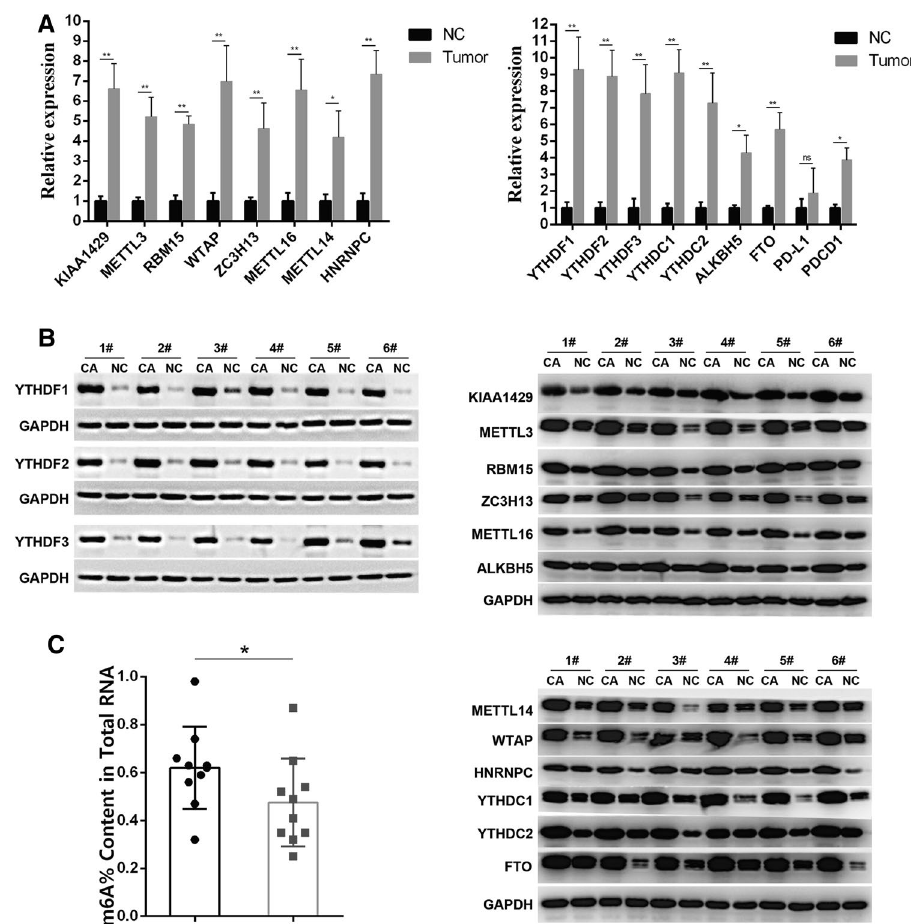
Fig. 9 Expression of m6A regulators in HCC. A Verify the expression of m6A regulators in HCC patients by qRT-PCR. B Western blotting was used to verify the expression of m6A regulators in patients with HCC. C Global RNA m6A methylation of HCC was evaluated by the m6A RNA Methylation Quantification Kit. The m6A contents of total RNAs in tumor tissues(n = 10) paired with para-tumor